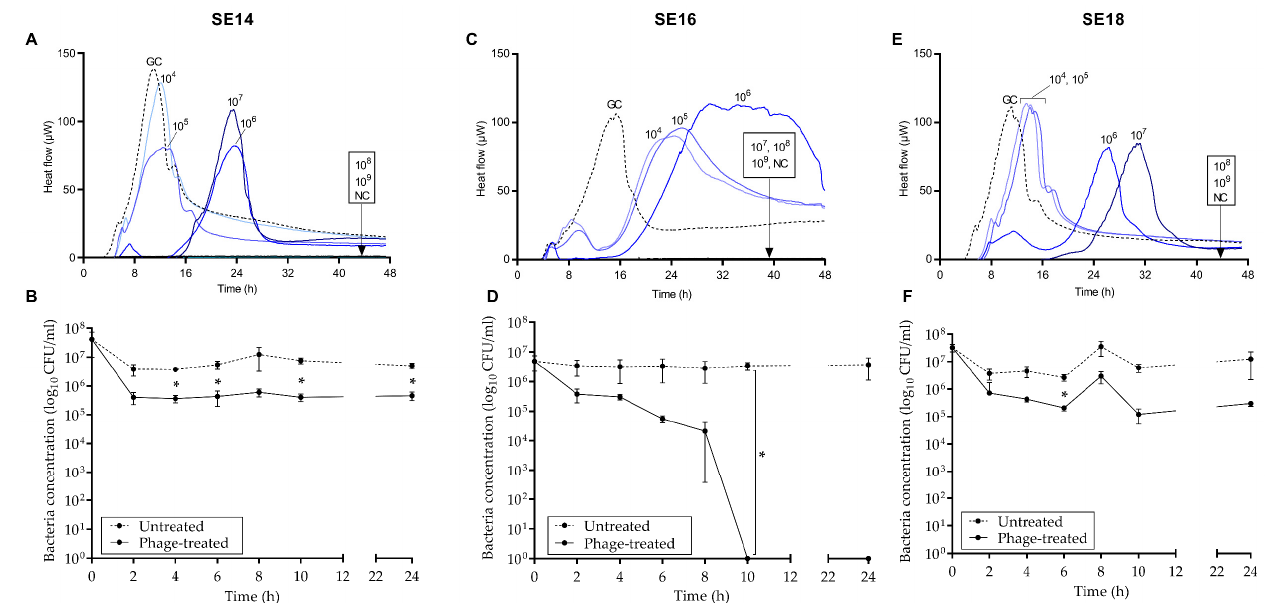
Figure 5. Microcalorimetric heat-flow curves ( µ W over time) of planktonic (10 5 CFU/mL) SE14 ( A ), SE16 ( C ), and SE18 ( E ) co-incubated with phage CUB-EPI_14 at different titers (10 4 to 10 9 PFU/mL). GC, growth control; NC, negative control. Data of a representative experiment are reported. Time- killing curve of SE14 ( B ), SE16 ( D ), and SE18 ( F ) biofilms treated with CUB-EPI_14 (10 8 PFU/mL) and untreated monitored at 2 h intervals for the first 10 h and after 24 h. Data are expressed as mean ± SD. Multiple paired Student’s t -test was performed; p -values < 0.005 were considered significant (*).